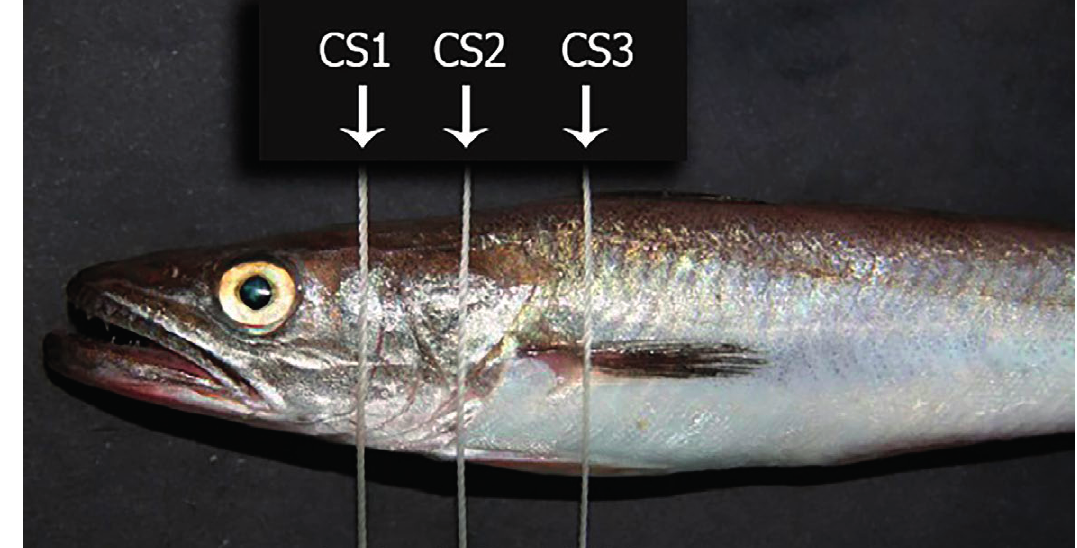
Fig. 1. – Illustration showing the positions along a hake of the three cross-sections (CS1, CS2 and CS3).